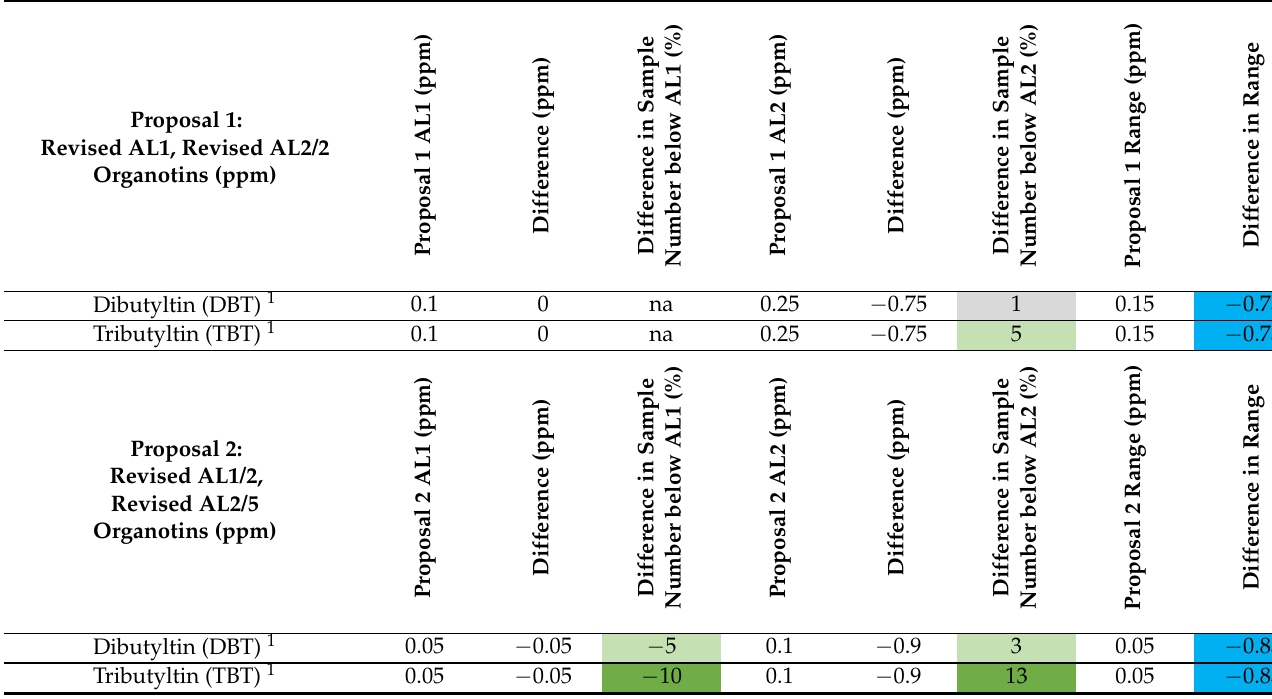
Figure 7. Maps showing the differences between the current ALs and revised ALs for organotins (DBT and TBT). Samples above AL2 are indicated in red. Figure adapted from [13]. Table 9. Organotins (DBT, dibutyltin; TBT, tributyltin)—Proposals 1 and 2 Difference (proposal − current) in the percentage of samples below AL1, above AL2 for revised ALs and the range of values between AL1 and AL2. Please note values (green) are more protective and values (orange) are more permissive (colour codes defined in Tables 2 to